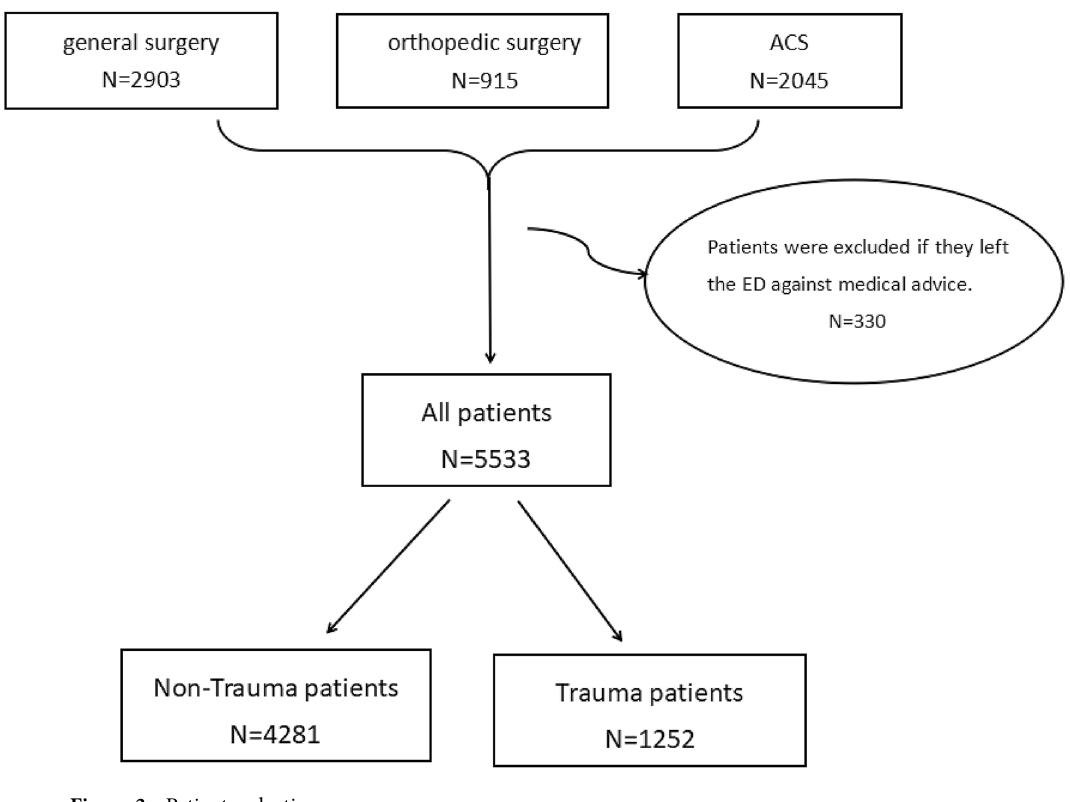
Figure 3. Patients selection